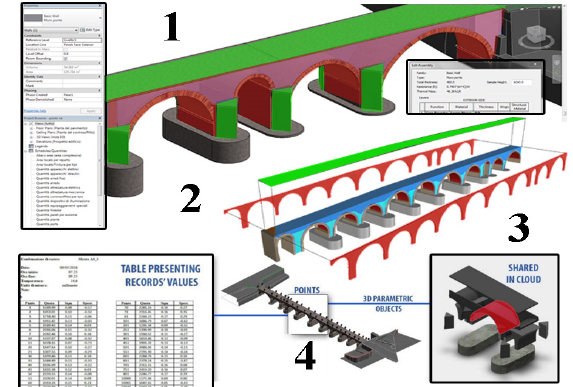
Fig. 7. Basilica of Collemaggio: Revti model (1), BIM for structural analysis (2), Design BIM (3) and HBIM: in red the elements where GoG 10 has been used, in green GoG09 and in blue the other types of GoGs. (4)